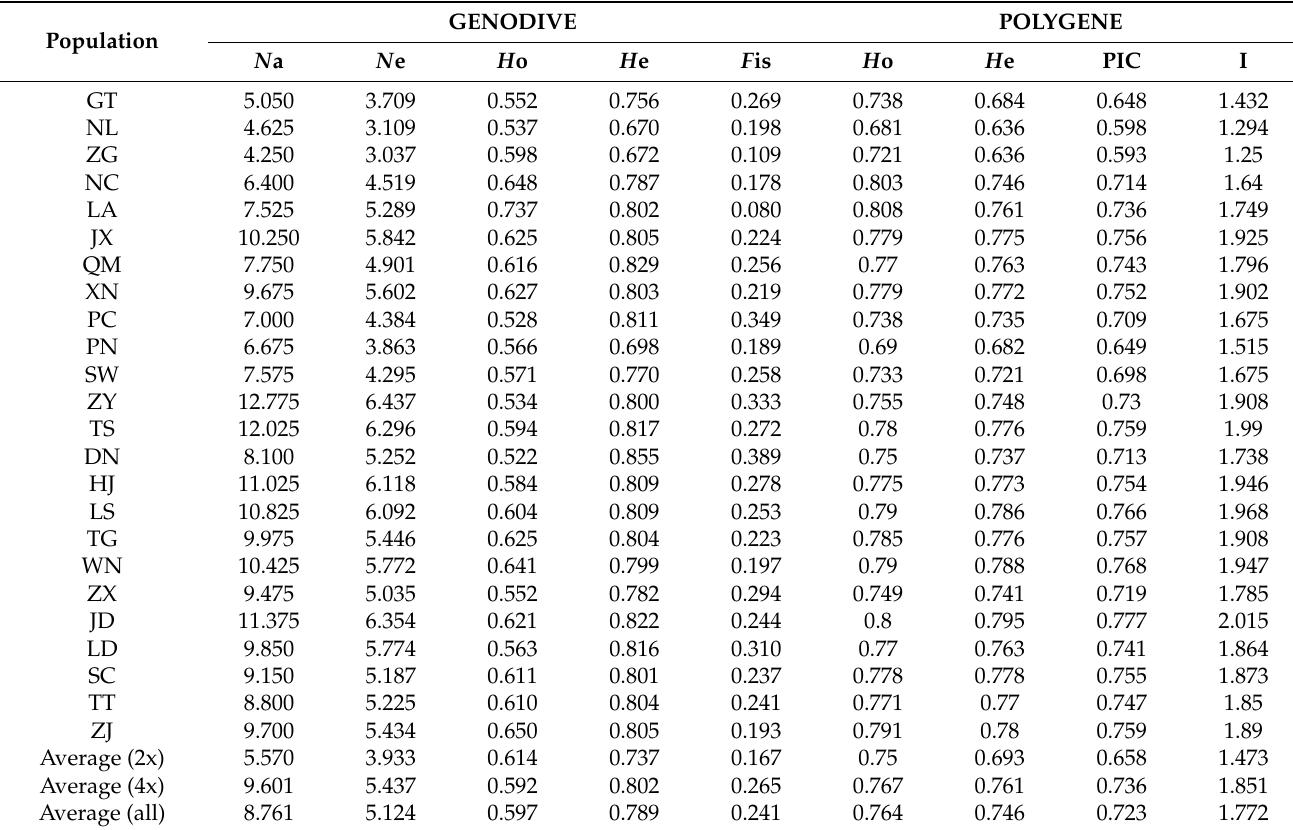
Table 1. Genetic diversity of 24 A. chinensis populations based on 40 SSR markers.